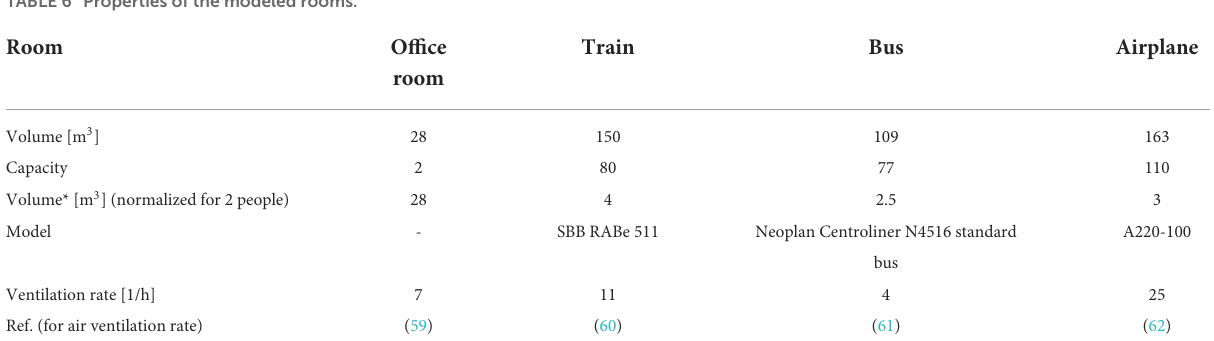
TABLE 6 Properties of the modeled